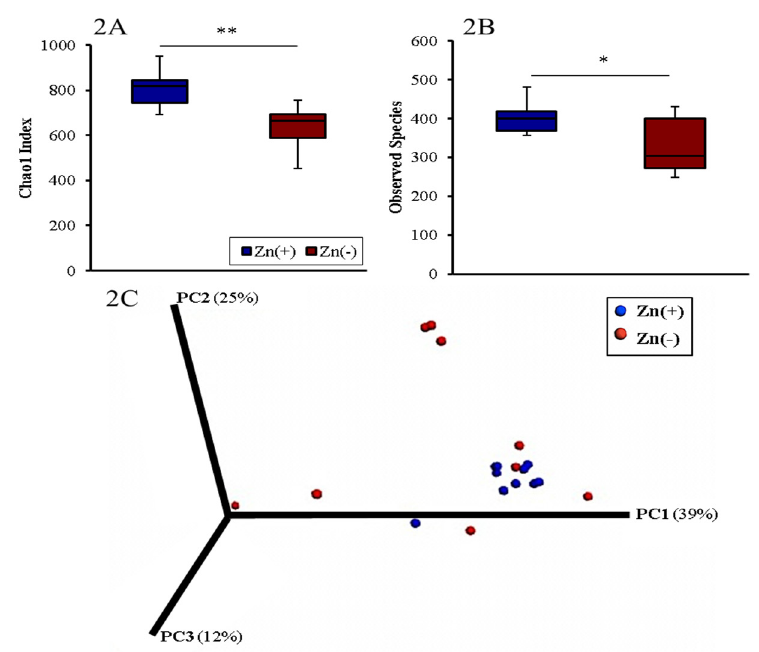
Figure 2. Microbial diversity of the cecal microbiome. ( A ) Measures of α‐ diversity using the Chao1 Index [39]; and ( B ) total number of observed species * p < 0.05, ** p < 0.01, ANOVA, n = 10 in Zn(+), n = 9 in Zn( − ); ( C ) Measure of β‐ diversity using weighted UniFrac distances separated by the first three principal components (PC). Each dot represents one animal, and the colors represent the different treatment groups.